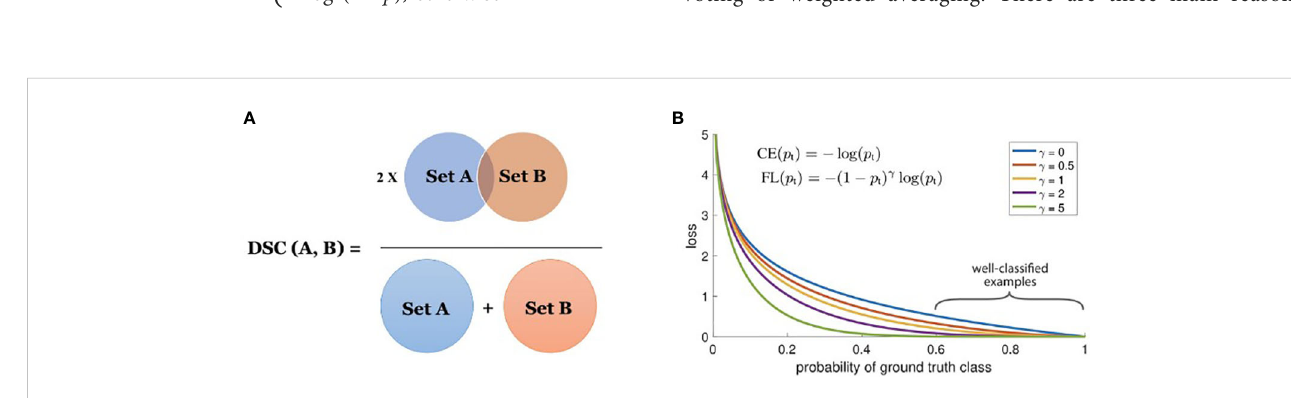
FIGURE 4 (A) Dice coef fi cient (set view); and (B) focal loss for g ∈